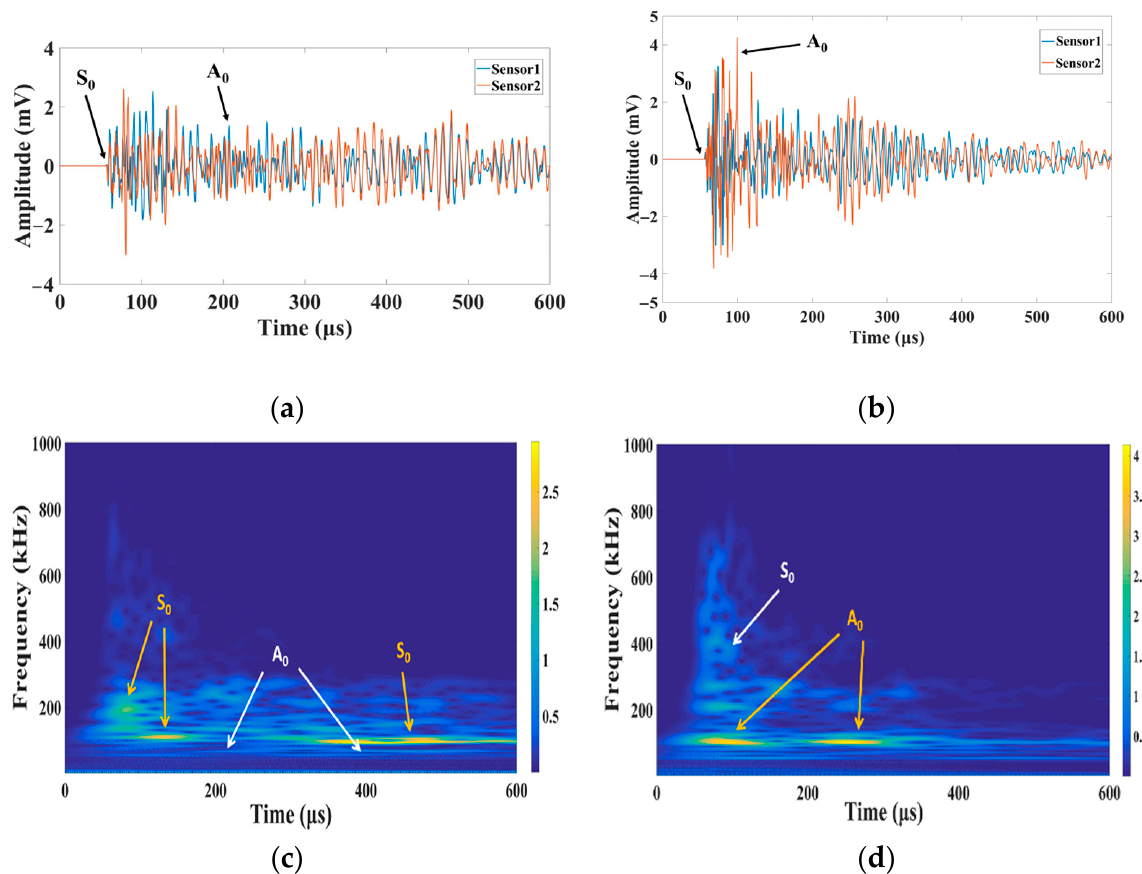
Figure 6. AE signal diagram: extracted lamb mode IP source ( a ) and OP source ( b ); CWT diagram: IP source ( c ) and OP source ( d ).